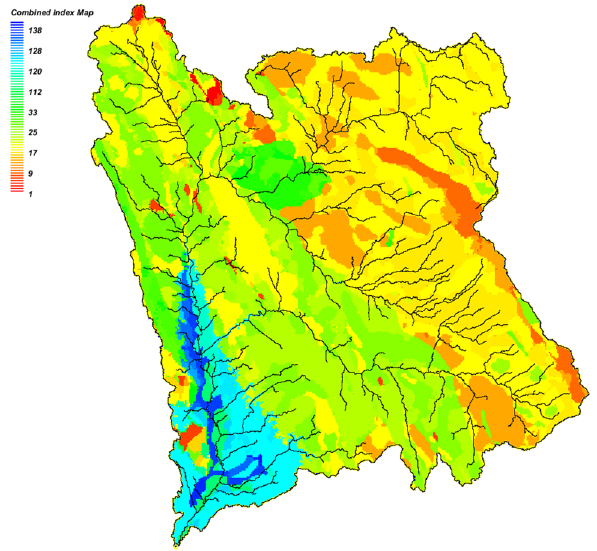
Fig. 12 Distributed model resulting from the combination of surface roughness and soil type in study watershed area to use in Green-Ampt infiltration